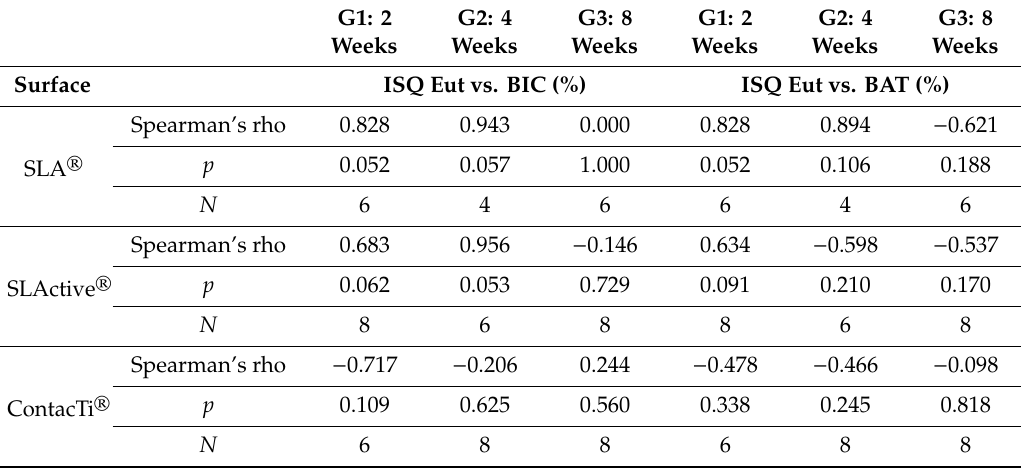
Table 5. Correlation between ISQEut and BIC, and between ISQEut and BAT for each implant system (surface) and time